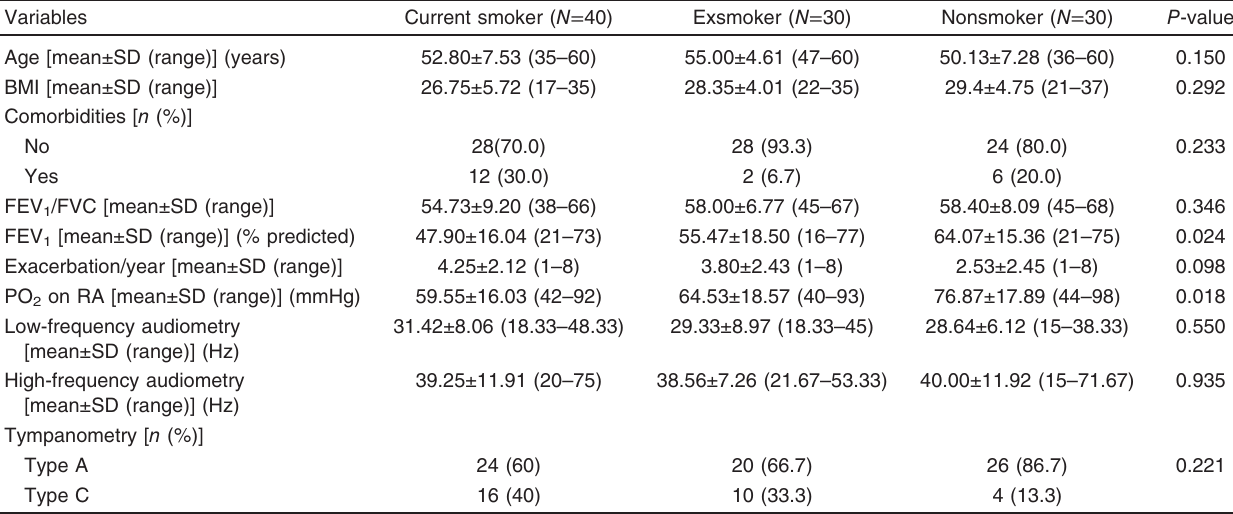
Table 4 Comparison between smoking statuses in chronic obstructive pulmonary disease Variables